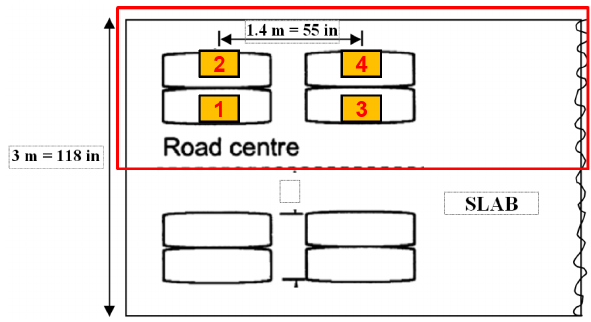
Figure 5: Wheel configuration on the slab [50]